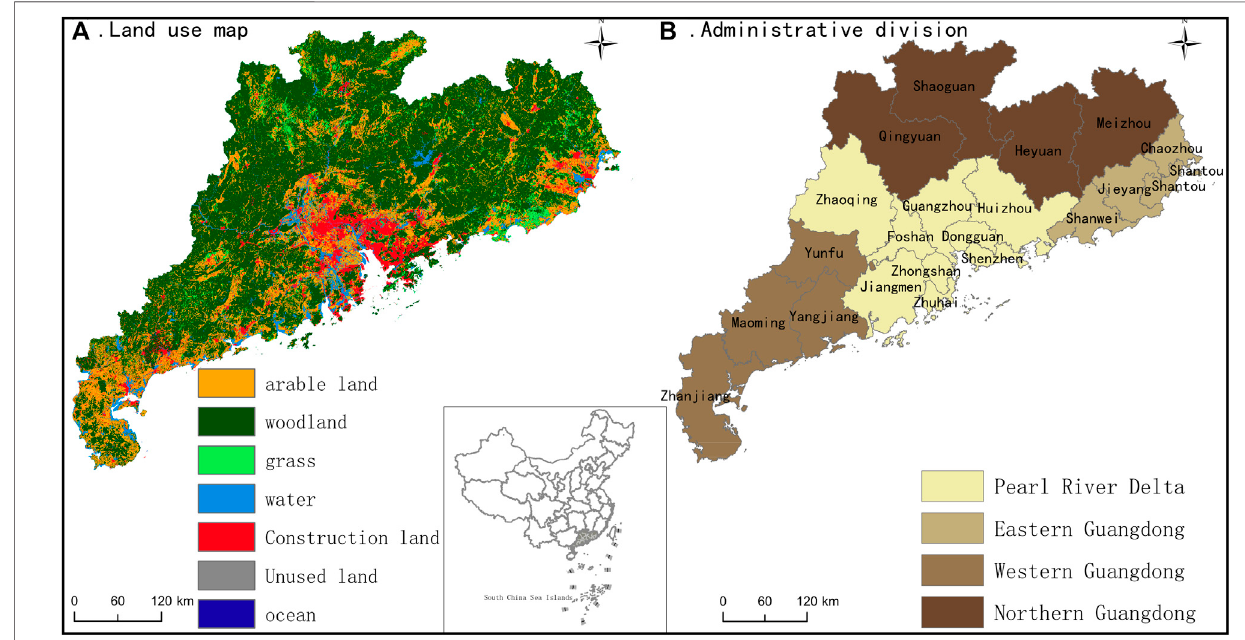
FIGURE 1 | Land use (A) and administrative division (B) map in Guangdong Province.